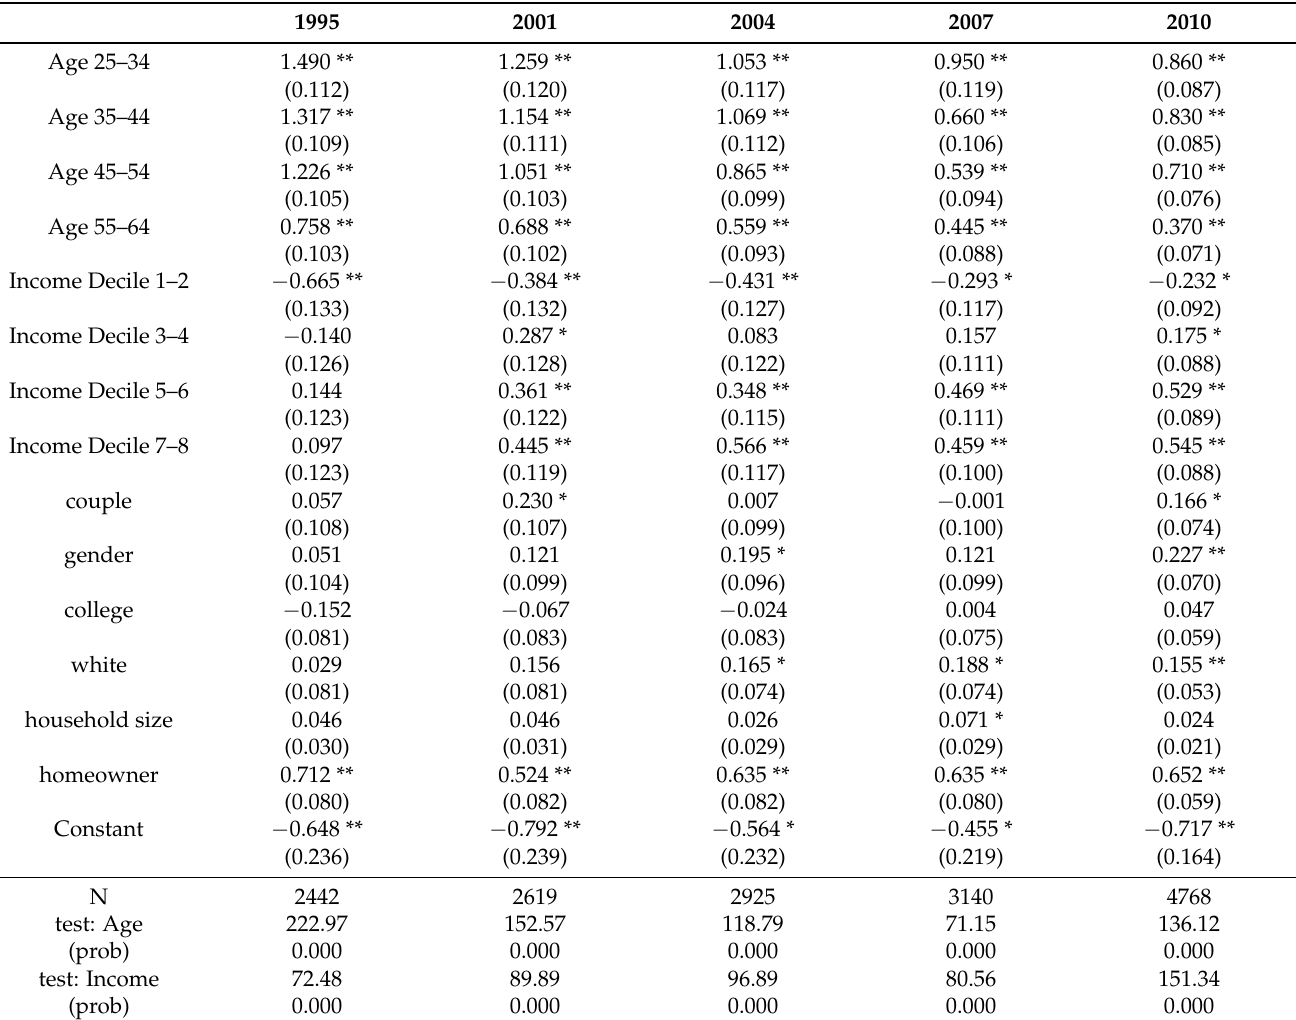
Table A3. Probability of Applying for a